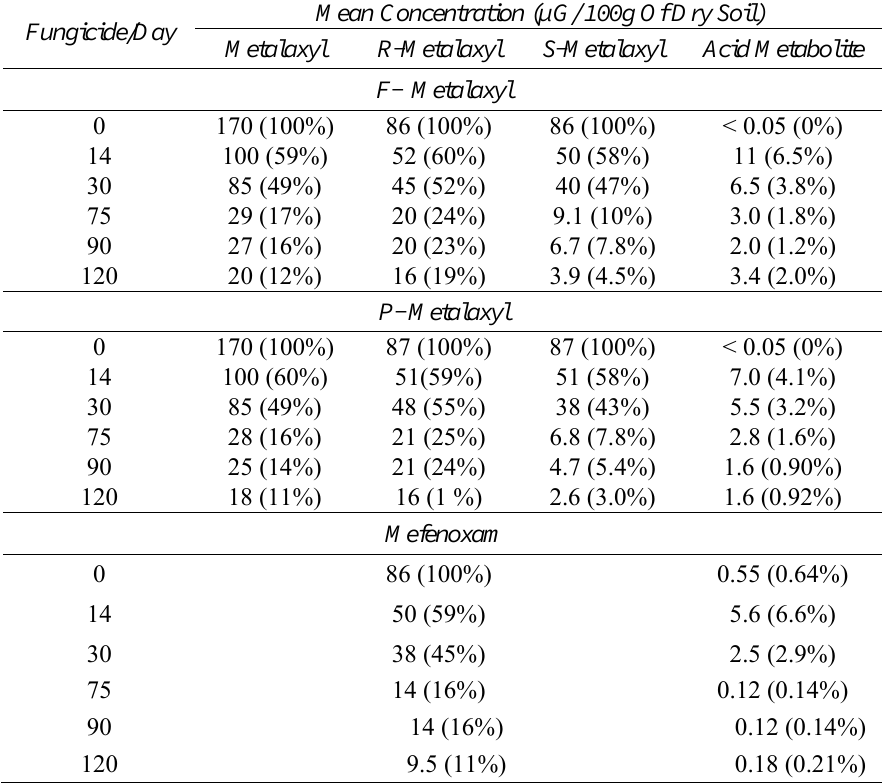
Table 4: Concentrations of metalaxyl and its Enantiomers as well as the metabolite in the Cameroonian soil after the respective incubation